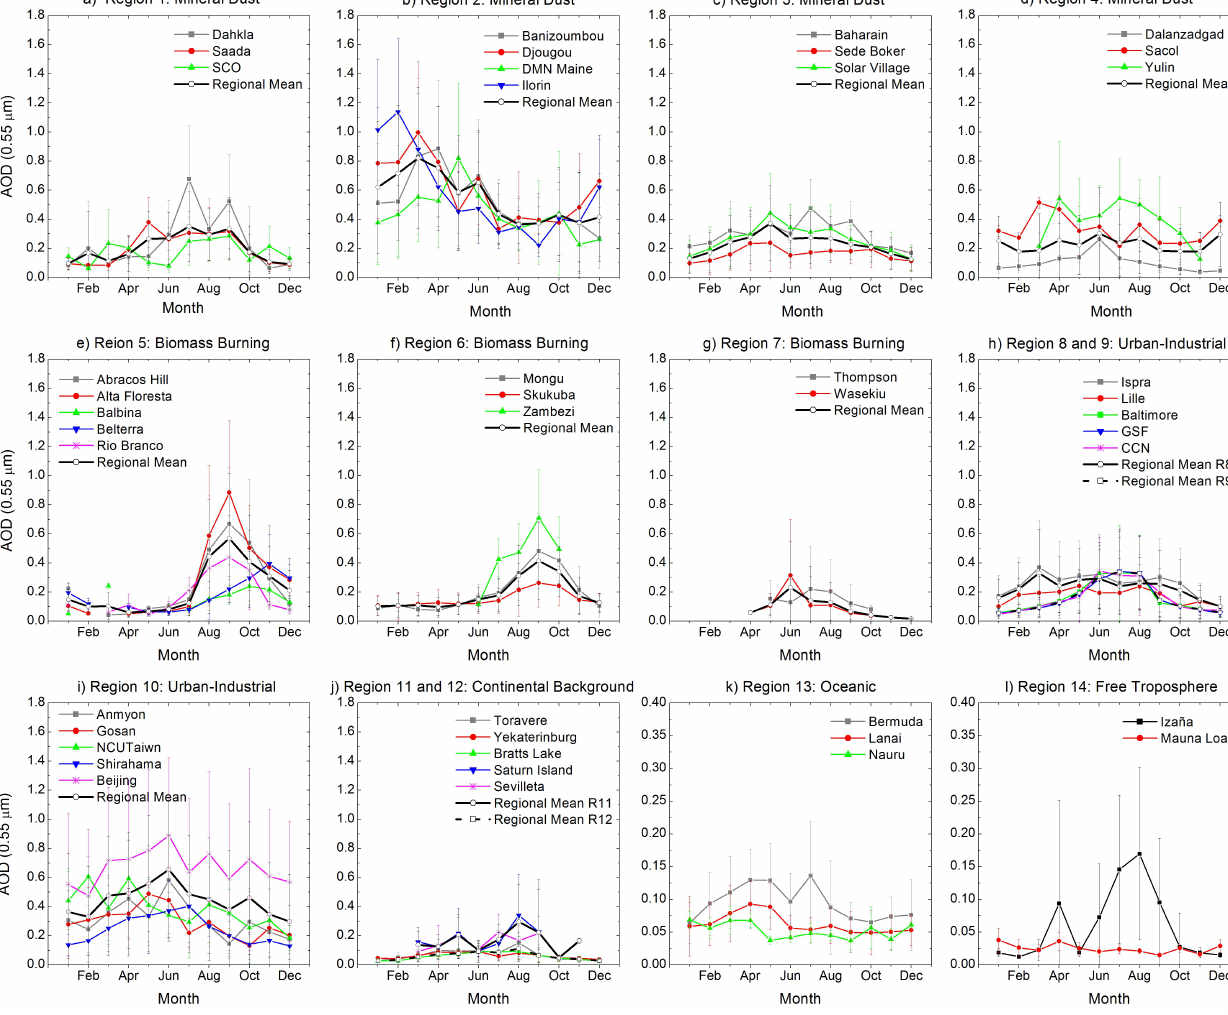
Fig. 2. Monthly evolution of the multi-year average of the aerosol optical depth, AOD, at 0.55µm for each station of region 1 (a) , region 2 (b) , region 3 (c) , region 4 (d) , region 5 (e) , region 6 (f) , region 7 (g) , region 8 and 9 (h) , region 10 (i) , region 11 and 12 (j) , region 13 (k) and region 14 (l) . The annual cycle of the regional mean is also shown (black lines). Error bars indicate ± 1 σ ( σ , standard